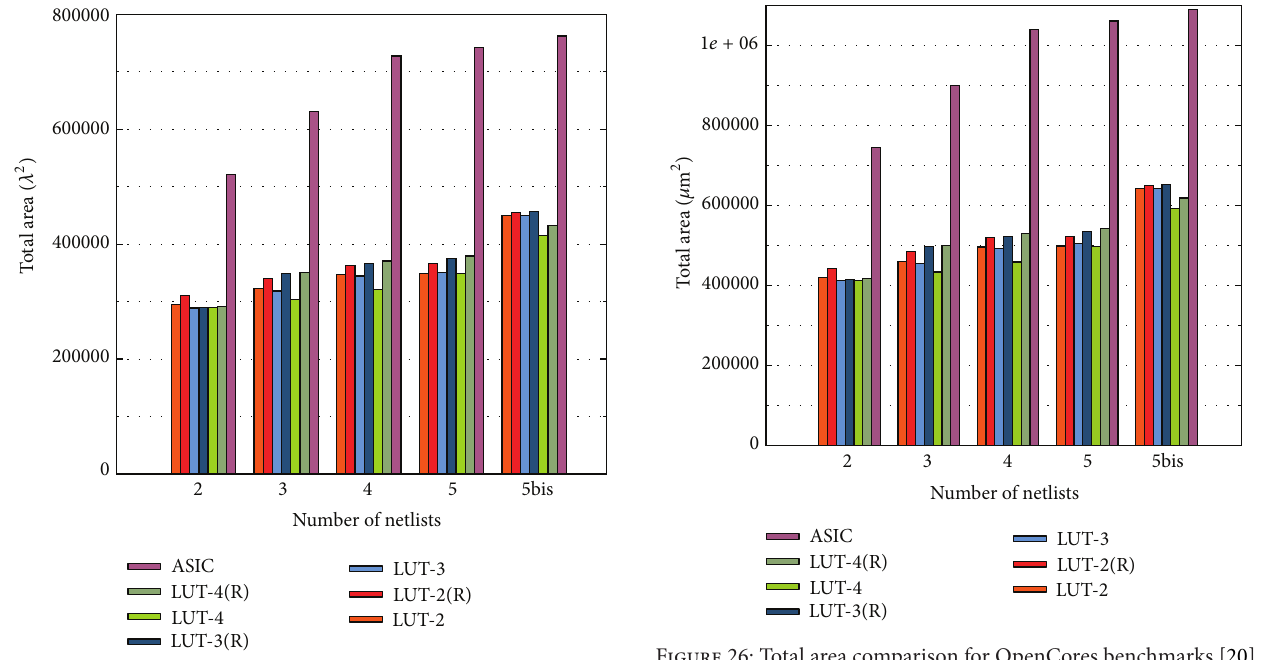
Figure 25: Total area comparison for OpenCores benchmarks [20] SET2.